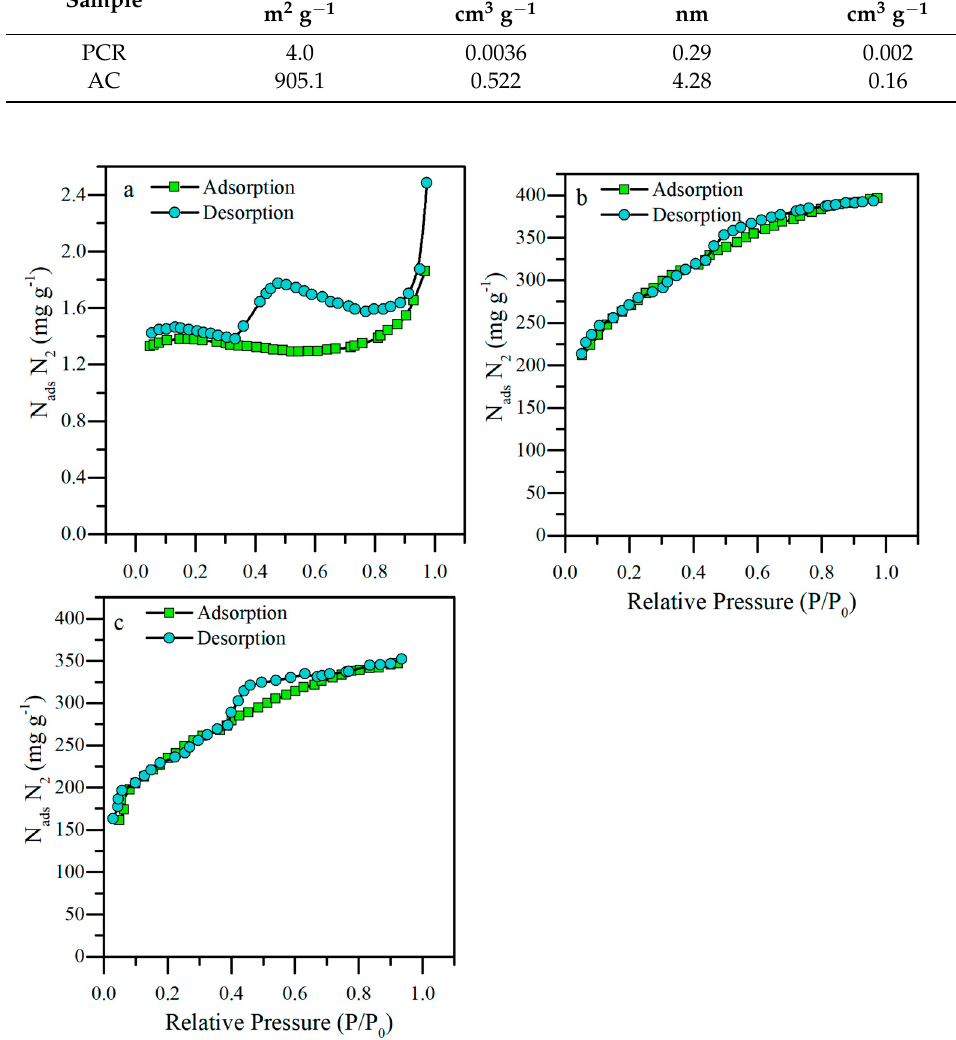
Figure 5. Adsorption/desorption isotherms N 2 at − 196 ◦ C of ( a ) pyrolyzed coffee residue (PCR), ( b ) synthesized activated carbon (AC) and ( c ) activated carbon modified with 5.0 wt.% of magnetite nanoparticles